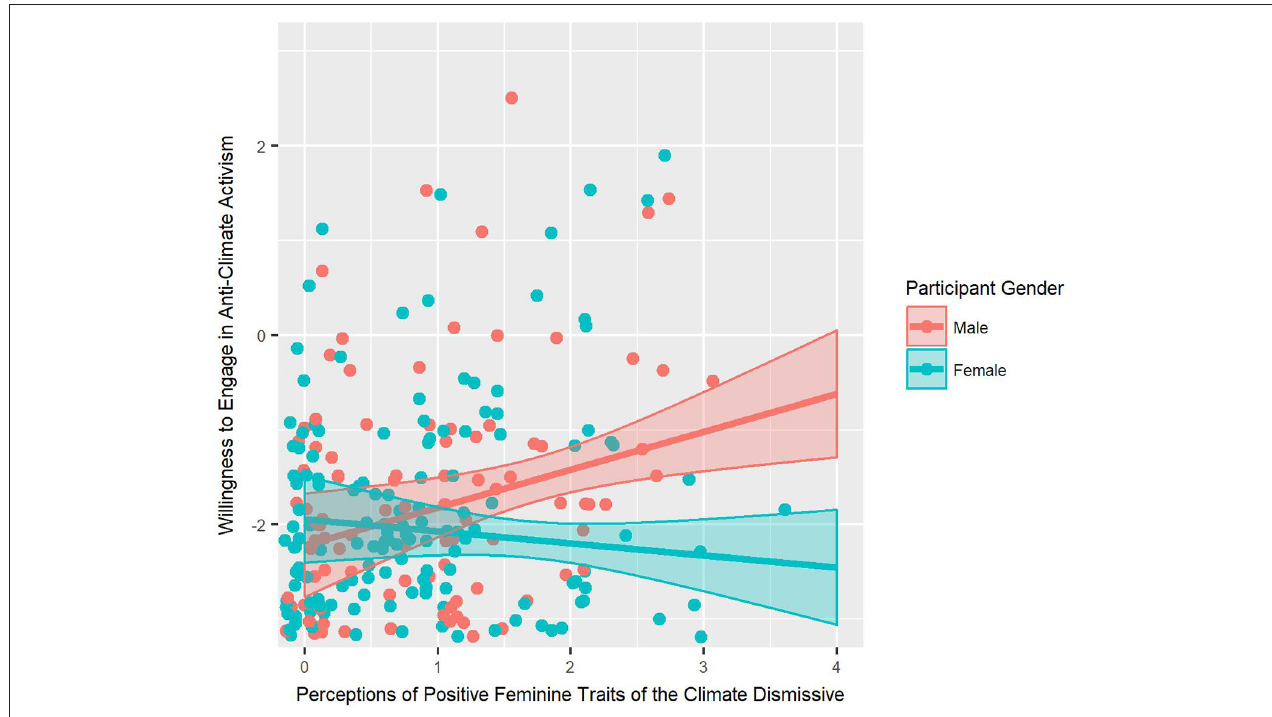
FIGURE 2 | Interactive effect of positive feminine trait perceptions of the climate dismissive and participants’ own gender on interest in engaging in anti-climate activism (Study 2).